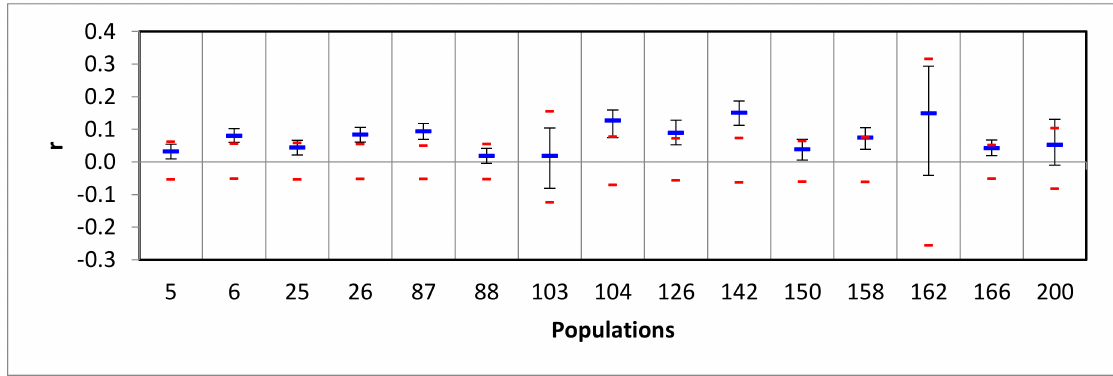
Figure 2. Mean relatedness (r) within the population, box plots (blue) represent average relatedness and standard error. Red bars represent 95% confidence intervals about zero, which is determined by sample